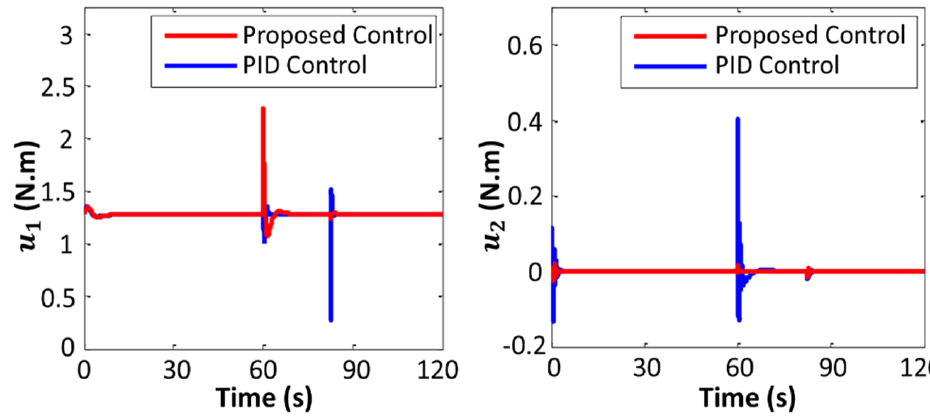
Figure 11. Variations in manipulated variables u 1 and u 2 .